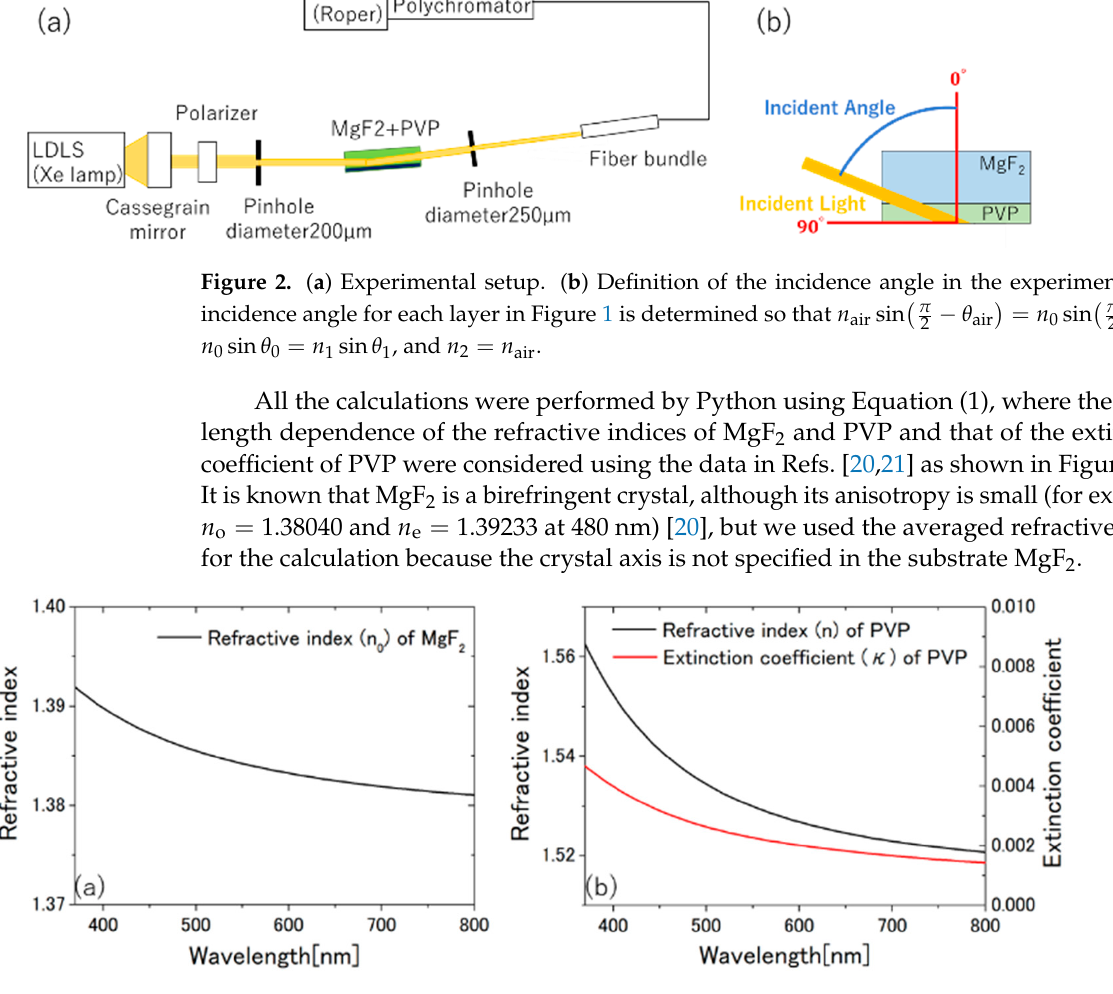
Figure 3. The wavelength dependence of the refractive index ( n 0 ) of MgF 2 ( a ), and that of the refractive index ( n ) and the extinction coefficient ( κ ) of PVP ( b ) [20,21].